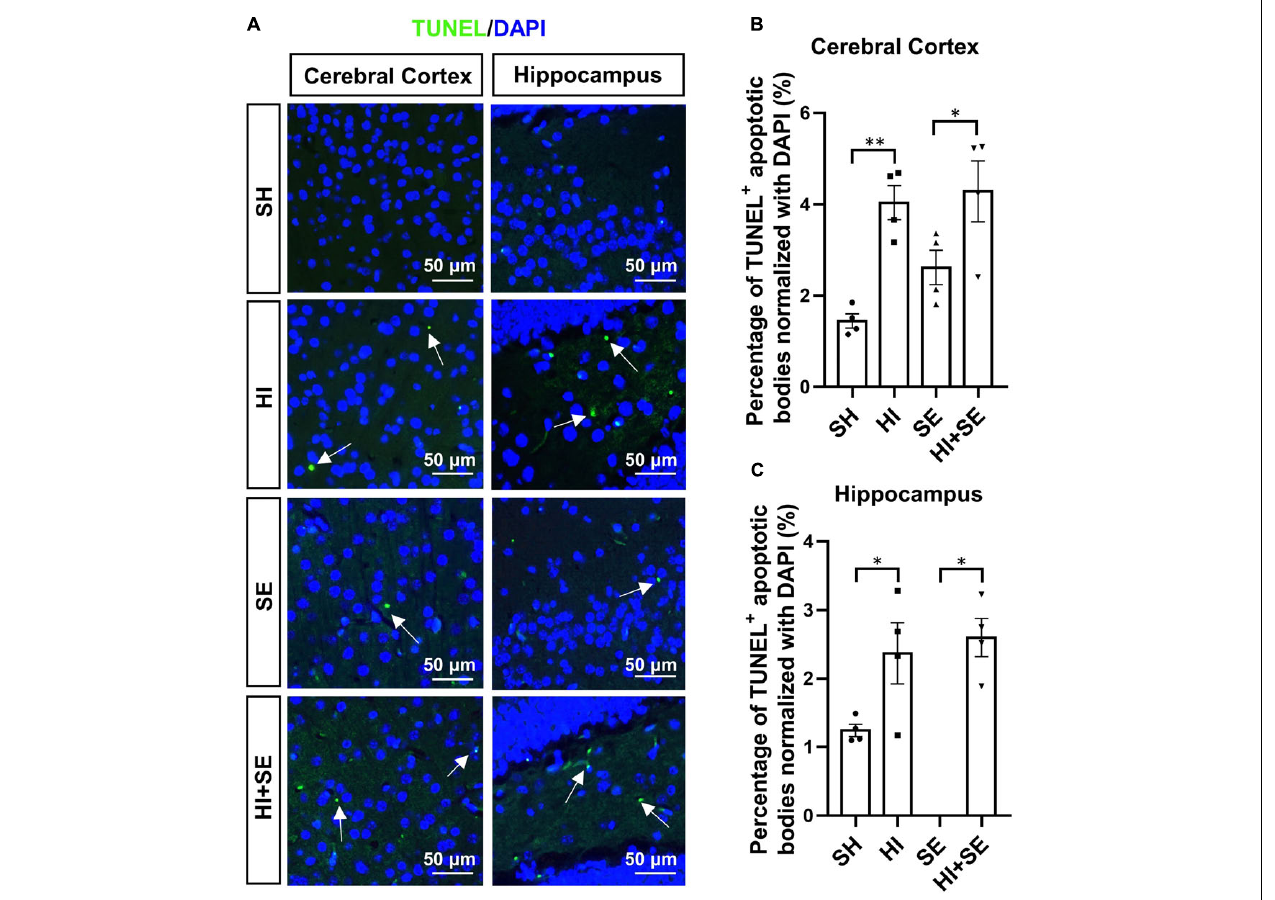
FIGURE 4 | HI injury increased cell apoptosis in the brain. Representative images of TUNEL staining in cerebral cortex and hippocampus (arrows: TUNEL positive apoptotic body) (A) . The percentage of TUNEL immunoreactive (TUNEL + ) apoptotic bodies in the cerebral cortex (B) and hippocampus (C) . Results are presented as mean ± SEM. ∗ P < 0.05, ∗∗ P < 0.01, n = 4, analyzed by two-way ANOVA followed by post hoc Turkey tests. SH, from sham exposed dams with sham surgery; HI, hypoxic-ischemic injury; SE, from smoke exposed dams with sham surgery; HI + SE, from smoke exposed dams with hypoxic-ischemic